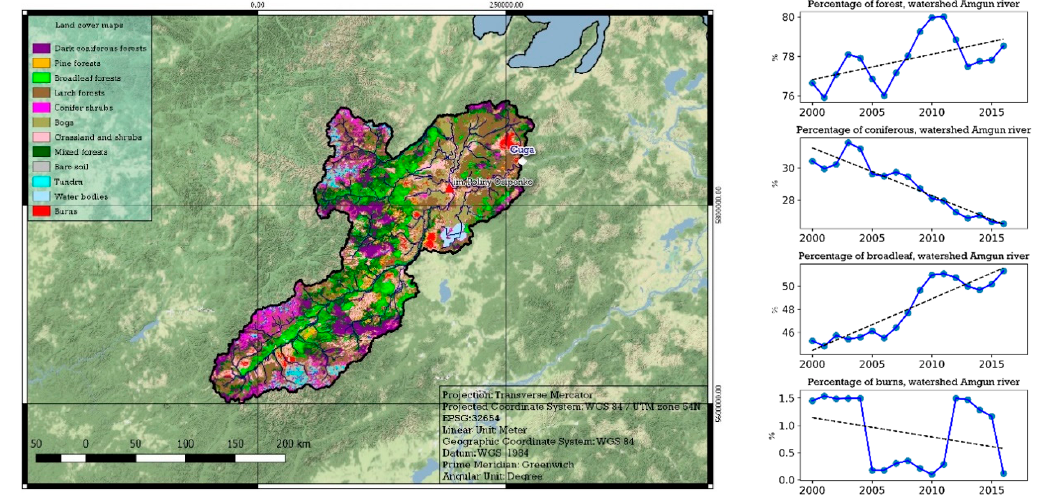
Figure 8. Vegetation dynamics of Amgun River watershed. Stream gaging is marked with the white diamond.